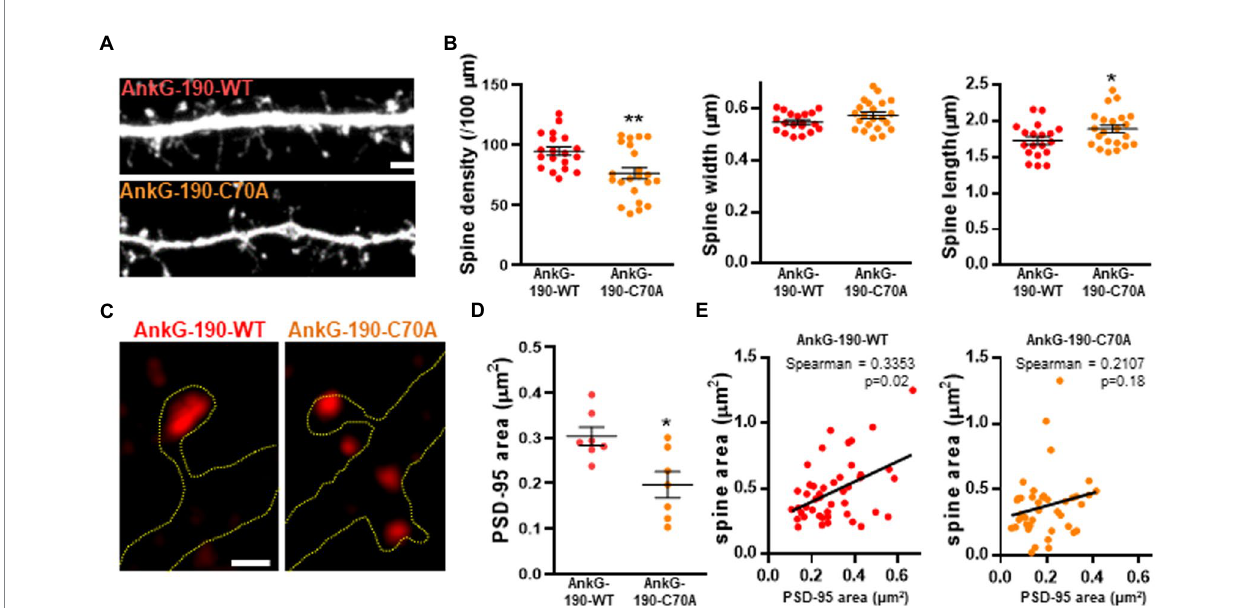
FIGURE 2 Effect of AnkG-190-C70A overexpression on dendritic spines. (A) Confocal images cultured cortical neurons expressing mCherry with GFP-AnkG190- WT or GFP-AnkG190-C70A, scale = 5 μ m. (B) Scatter plots showing quantification of spine density, spine width, and spine length for neurons expressing mCherry with GFP-Ank-G190-WT or GFP-AnkG-190-C70A ( n = 19–22 neurons, 1-way ANOVA with a Dunnett’s post-test, * p < 0.005, ** p < 0.01, ±SEM). (C) SIM images of PSD-95 from GFP-AnkG-190-WT and GFP-AnkG-190C-70A expressing, scale = 0.5 μ m. (D) Scatter plot graph showing a decrease of PSD-95 area in the spine with C70A mutation compared with WT ( n = 7 neurons, Mann Whitney, * p < 0.05, ±SEM). (E) Correlation plot of spine area vs. PSD-95 area (40 to 50 spines) for GFP-AnkG-190-WT or GFP-AnkG-190-C70A